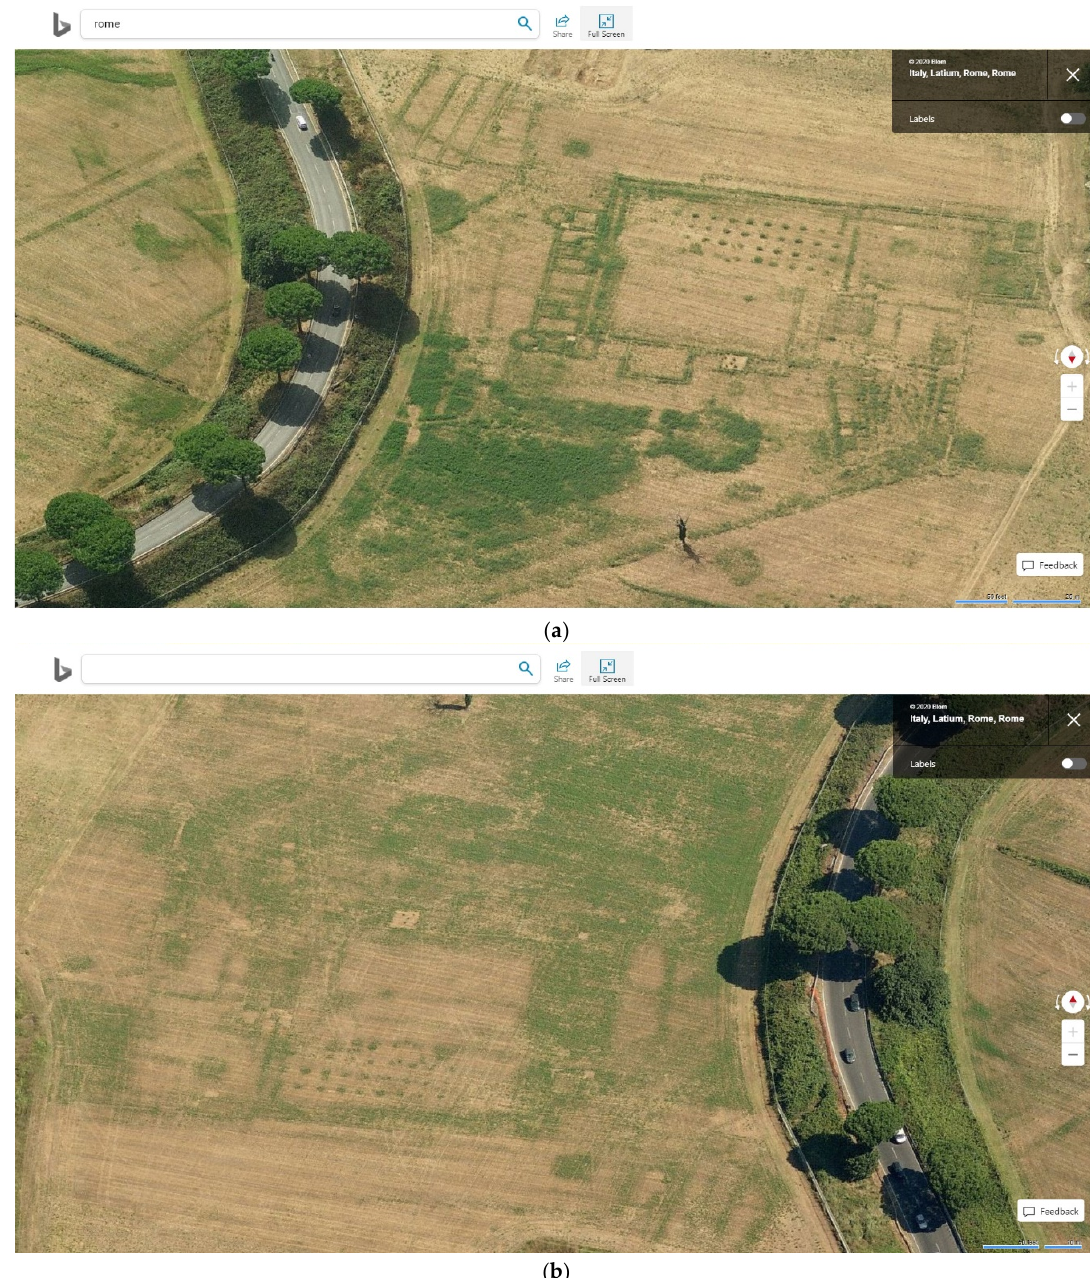
Figure 4. Cropmarks of archaeological structures in the area of the ancient Roman city of Ostia. The difference in the clarity of these cropmarks is apparent between the images acquired at different times (demonstrating the ephemeral nature of cropmarks) and orientations: one facing South ( a ), and the other facing North ( b ). Microsoft product screenshots reprinted with permission from Microsoft Corporation.